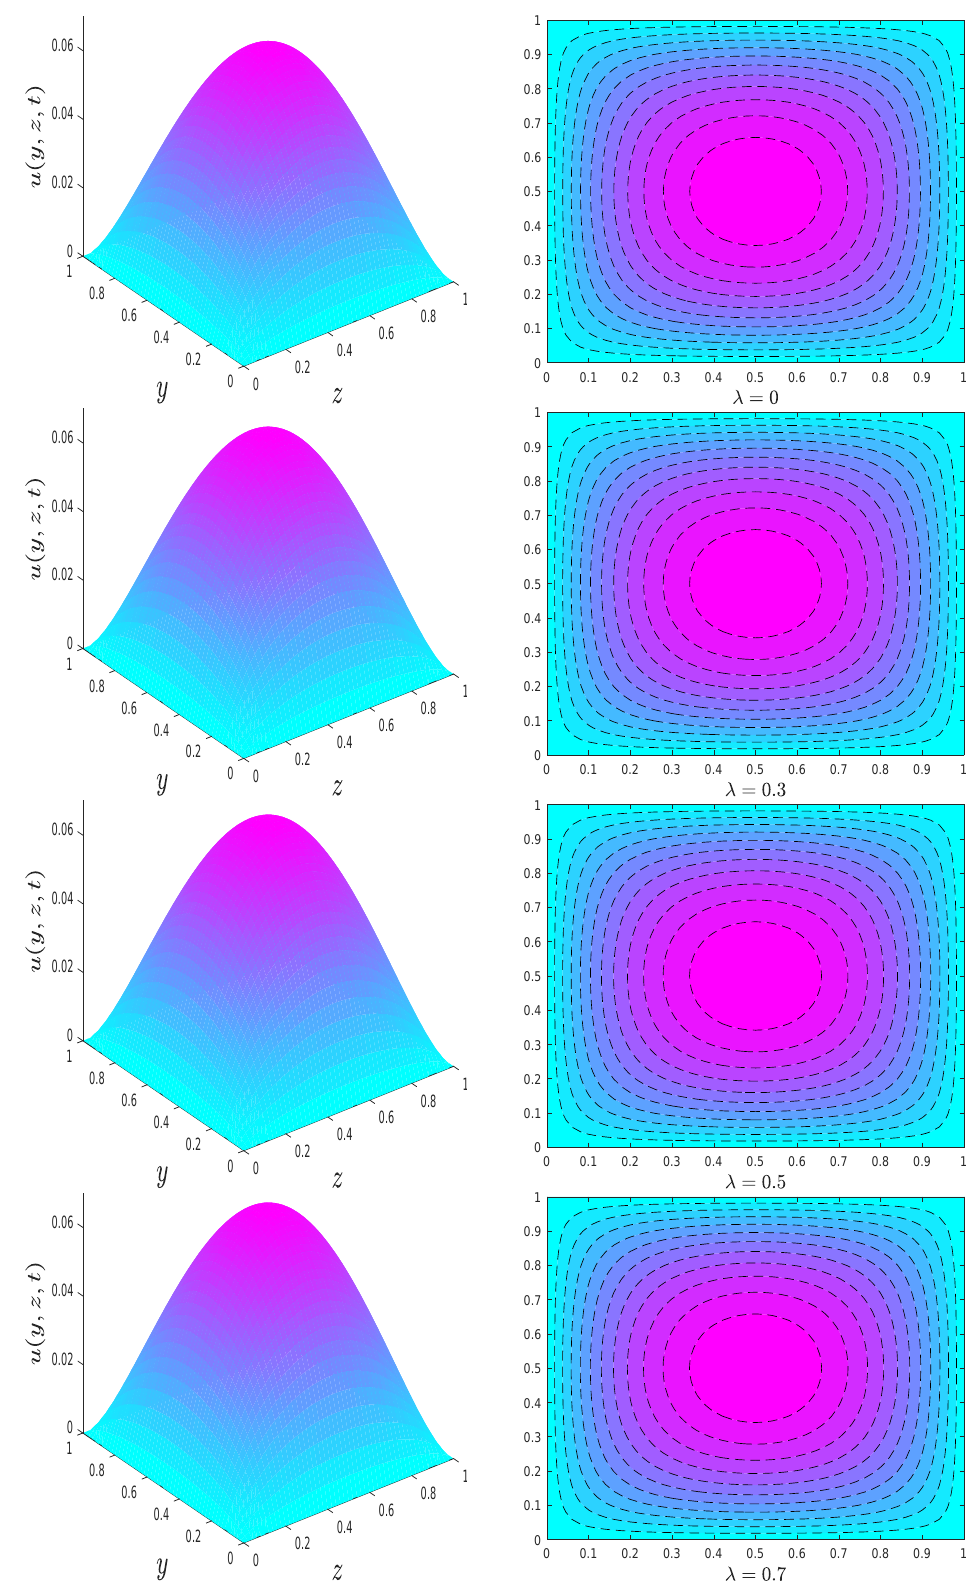
Figure 5. Velocity profile for different values of relaxation time parameter λ